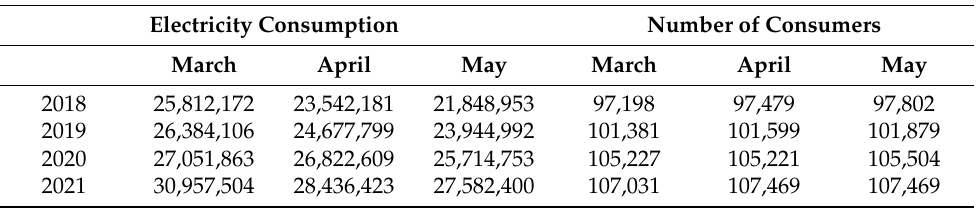
Table 5. Electricity consumption and the number of electricity consumers in Atyrau in March, April, and May for 2018–2021 in